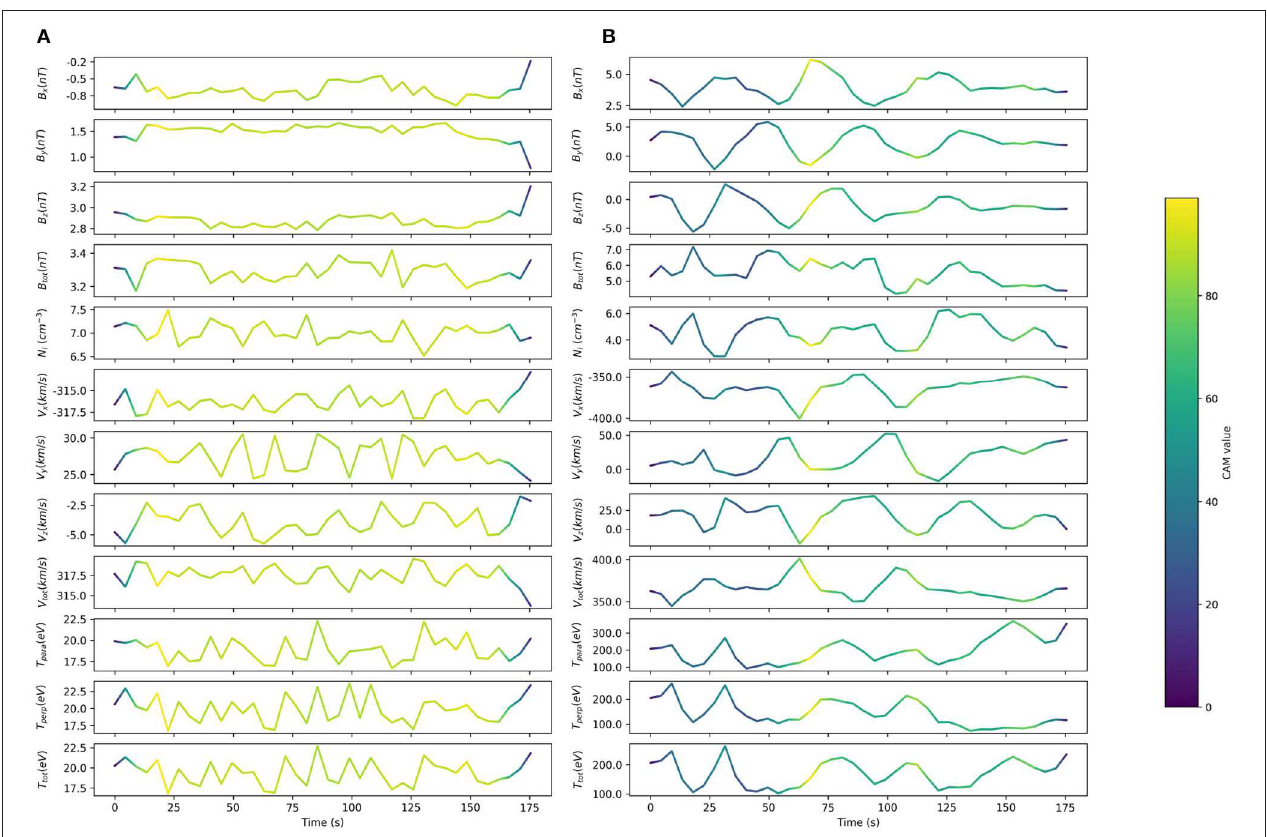
FIGURE 5 | The Class Activation Map highlighting the important sections of the time series contributing most to the classification. Low values mean the time step of the time series does not contribute to the decision of the classifier while high values mean the time step contributes significantly. (A) Solar wind. (B)